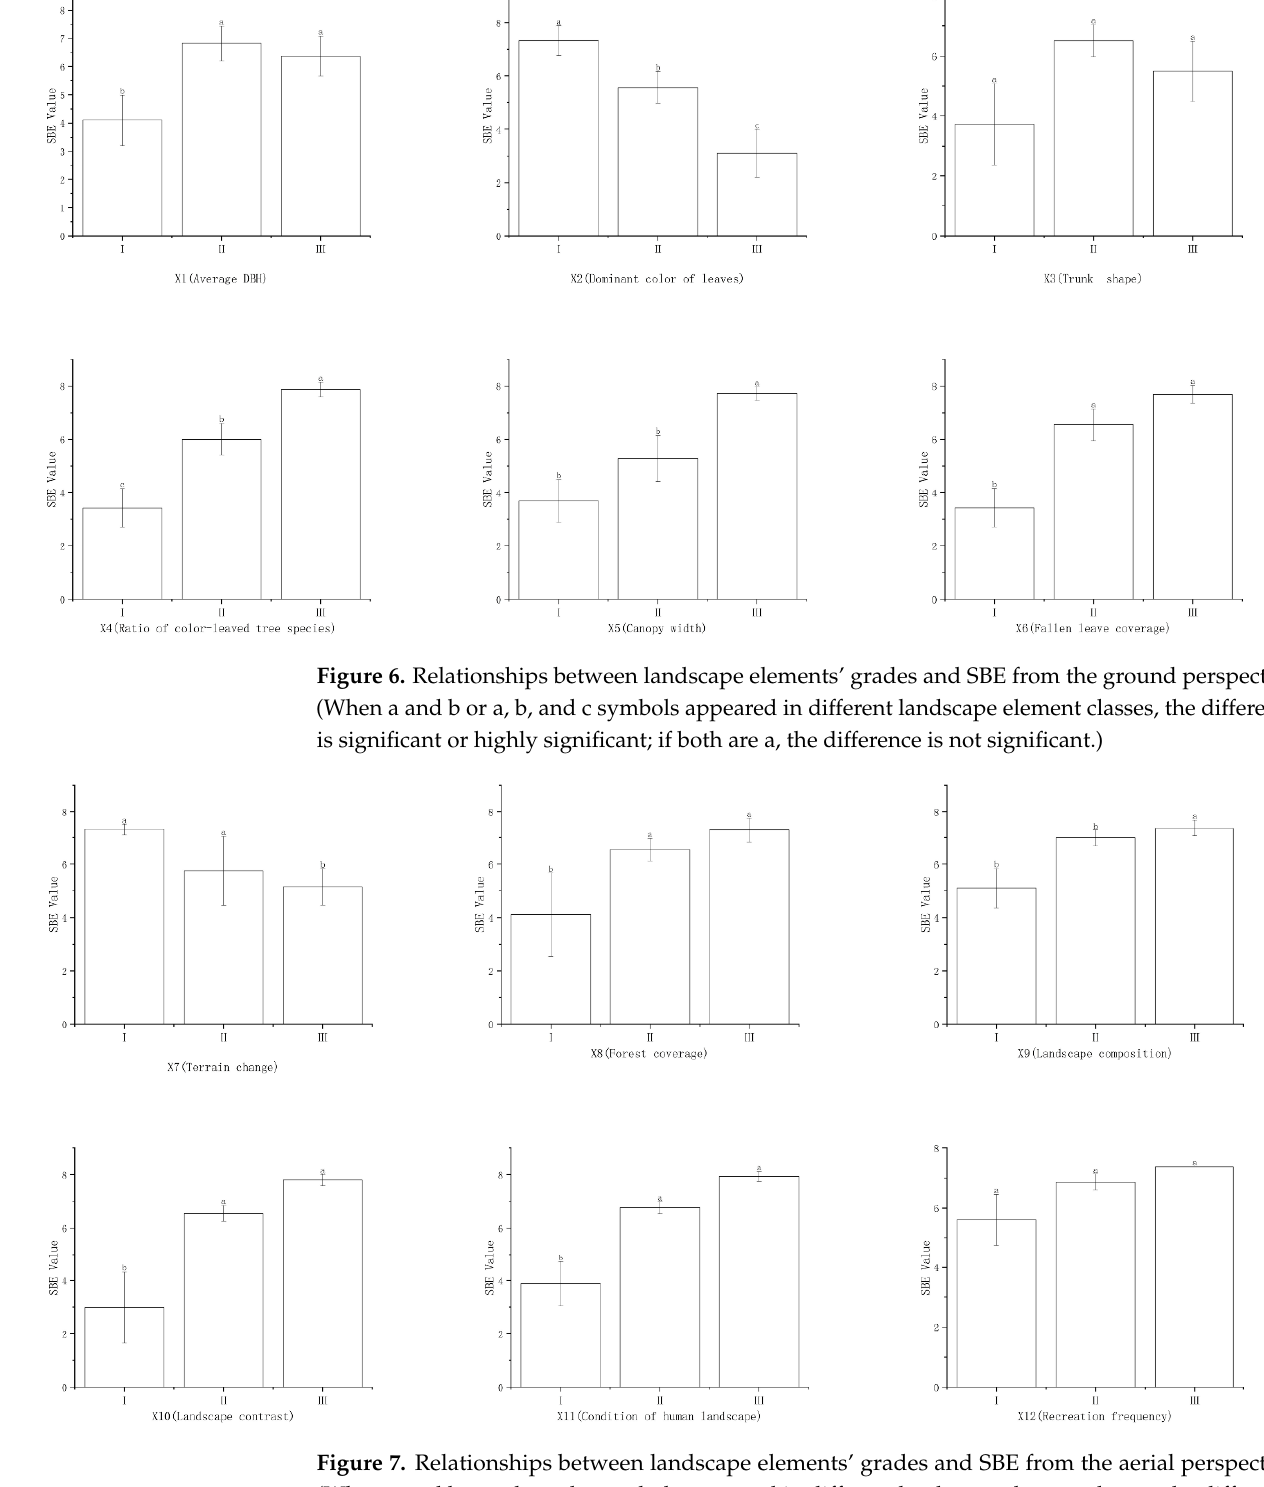
Table 5. Pearson correlation between landscape elements and SBE from the ground perspective. Landscape Elements